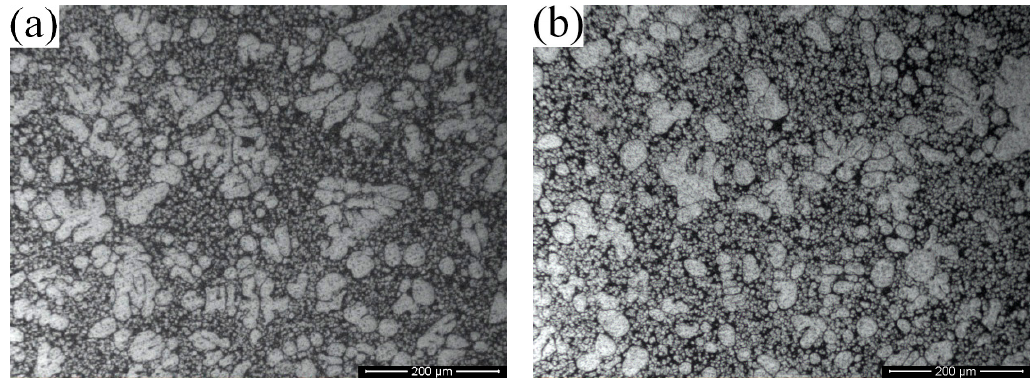
Figure 3. The microstructure of A356 alloy from different forming method ( a ) high pressure die casting at 680 °C and ( b ) semi-solid rheo-diecasting by SIM.